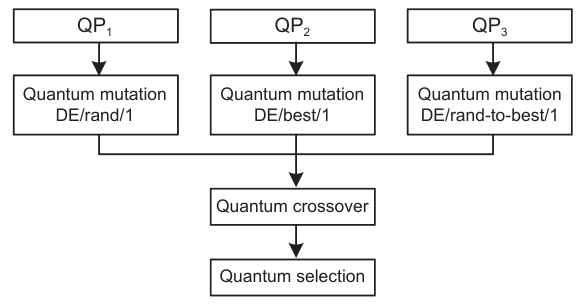
Fig. 2 Distributed quantum evolution on